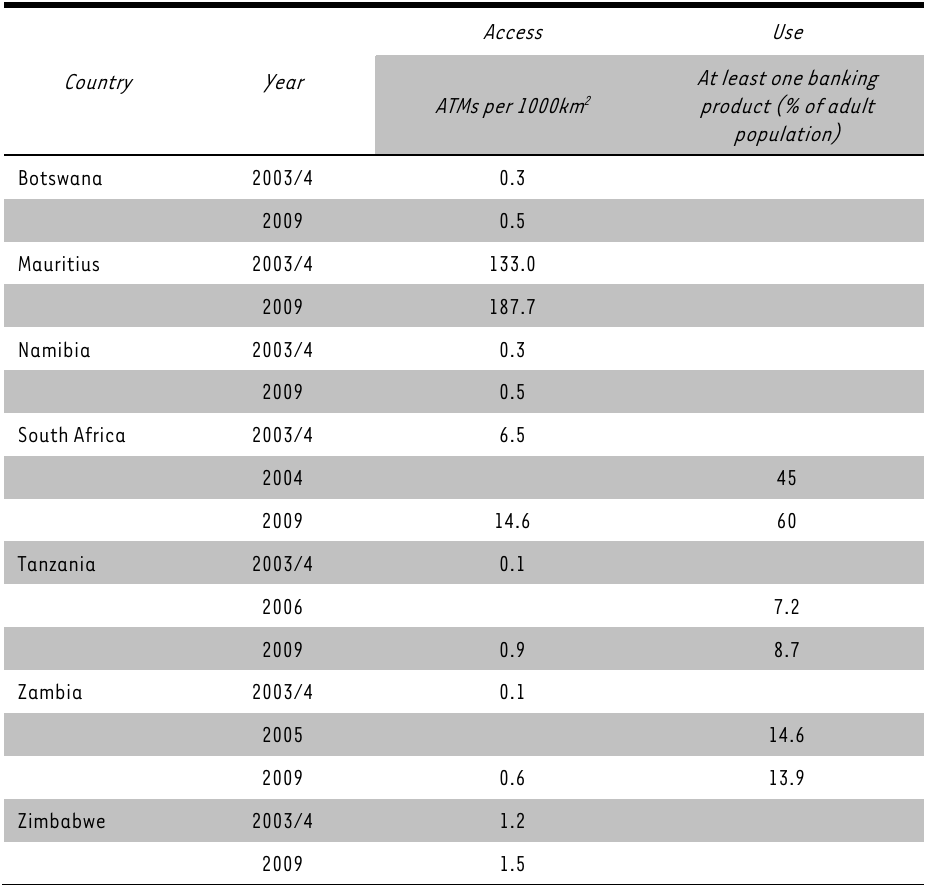
Changes in access to and use of banking